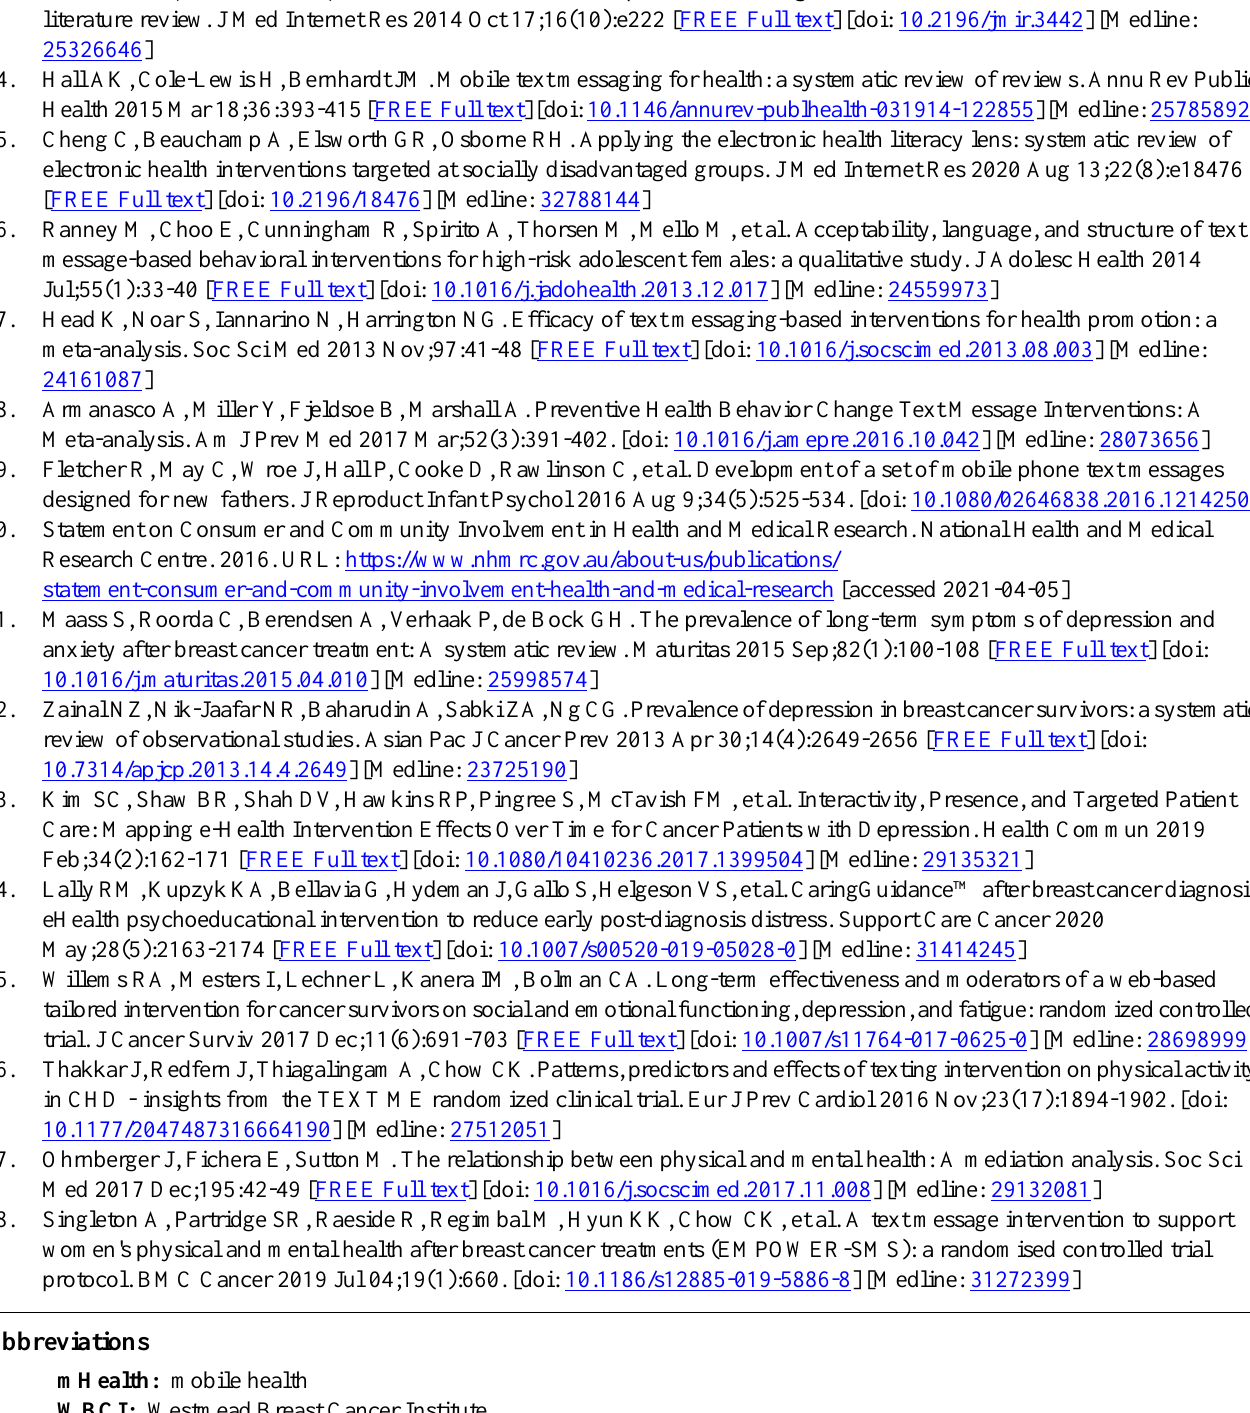
mHealth: mobile health WBCI: Westmead Breast Cancer